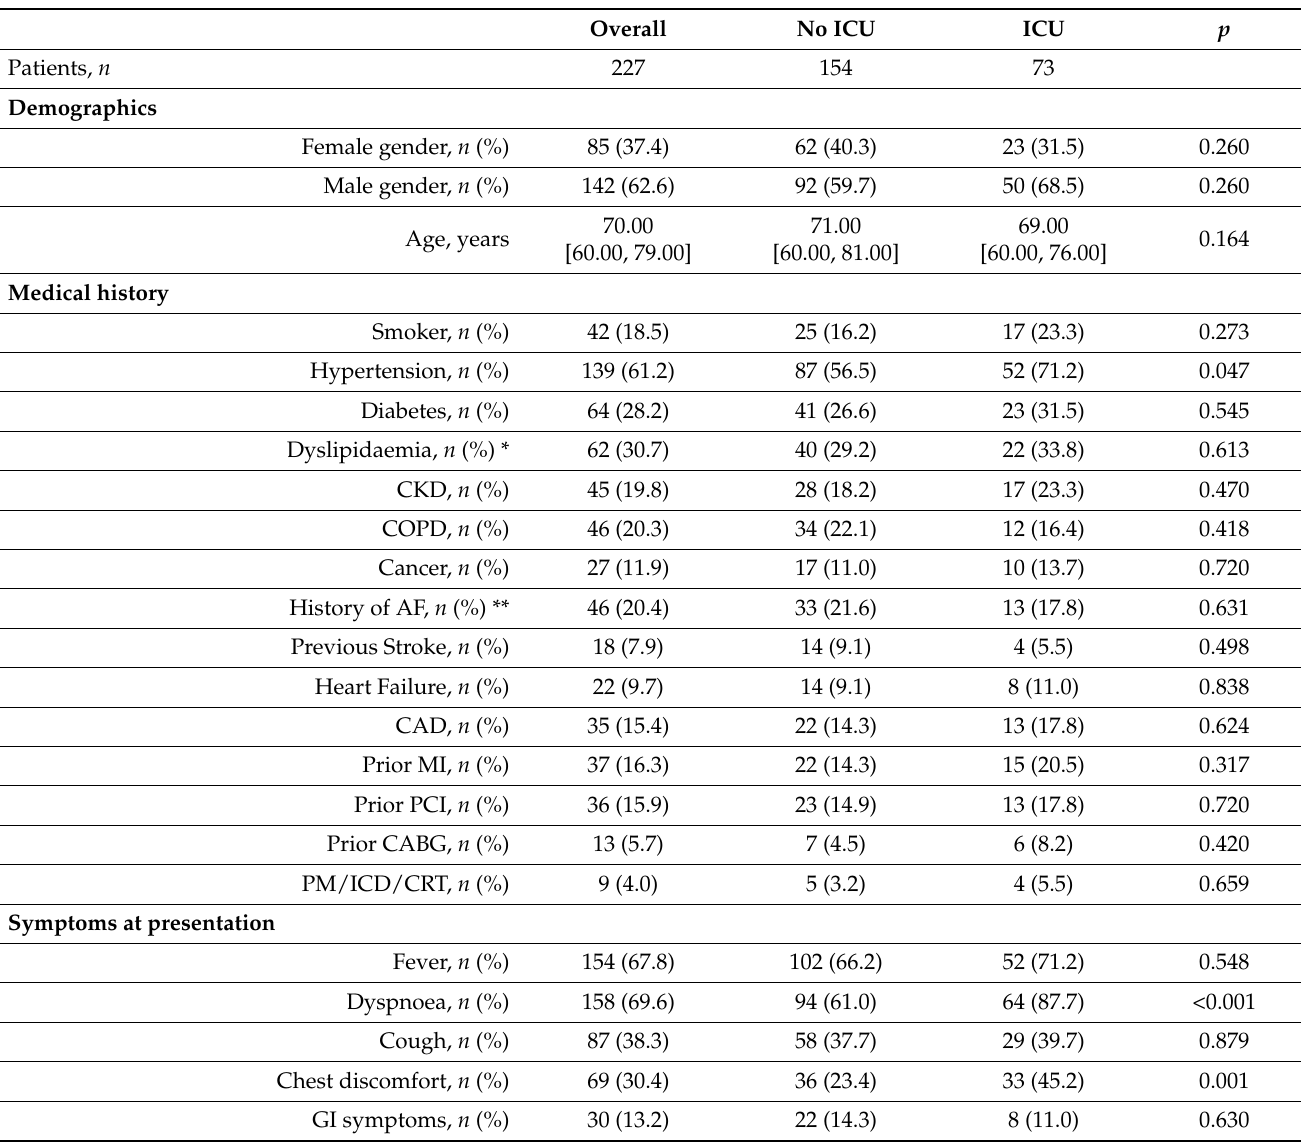
Table 1. Baseline characteristics of the study population according to the admission or not in ICU. Overall No ICU